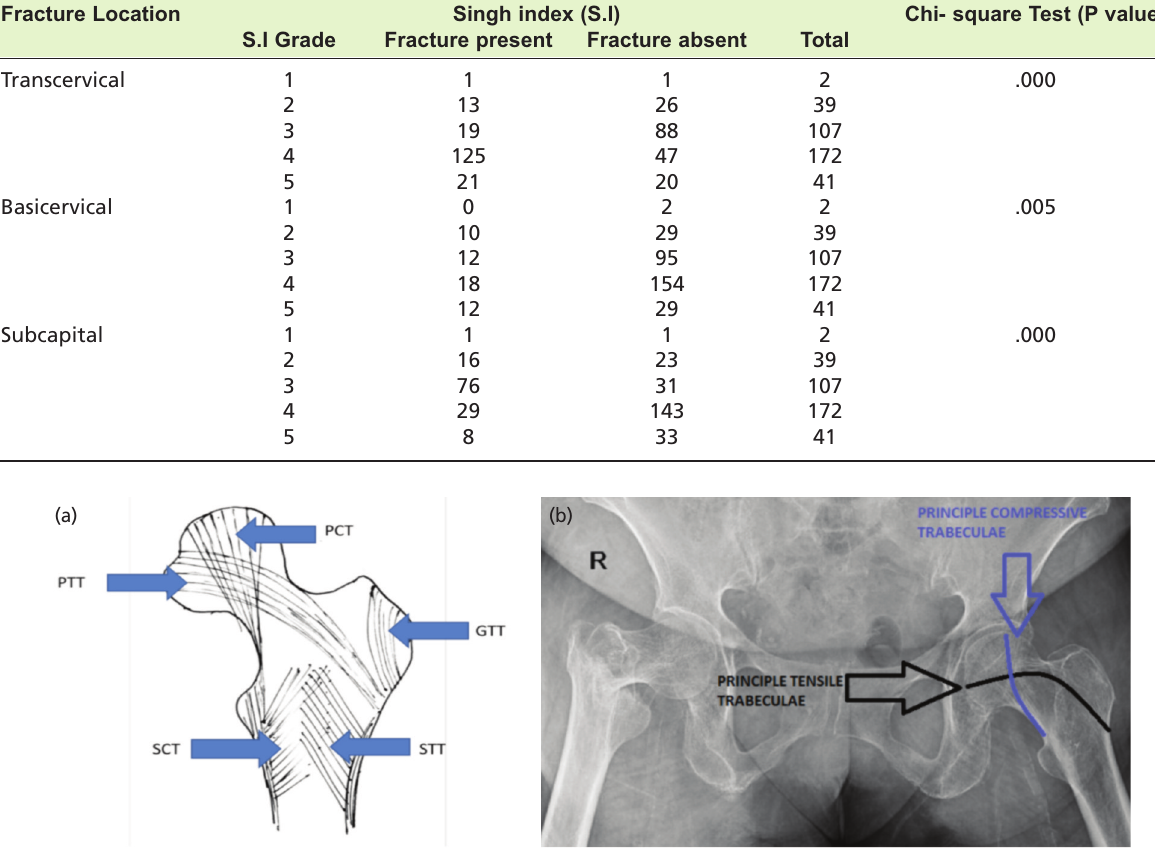
Descriptive statistics with crosstab between Singh index and fracture location Table VII: Fracture Location